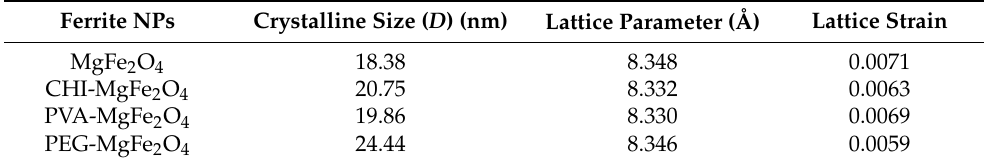
Figure 2. XRD patterns obtained for (a) MgFe 2 O 4 , (b) CHI-MgFe 2 O 4 , (c) PVA-MgFe 2 O 4 and (d) PEG- MgFe 2 O 4 MNPs. Table 1. Structural parameters of the MgFe 2 O 4 , CHI-MgFe 2 O 4 , PVA-MgFe 2 O 4 and PEG-MgFe 2 O 4 ferrite NPs obtained from XRD measurements.